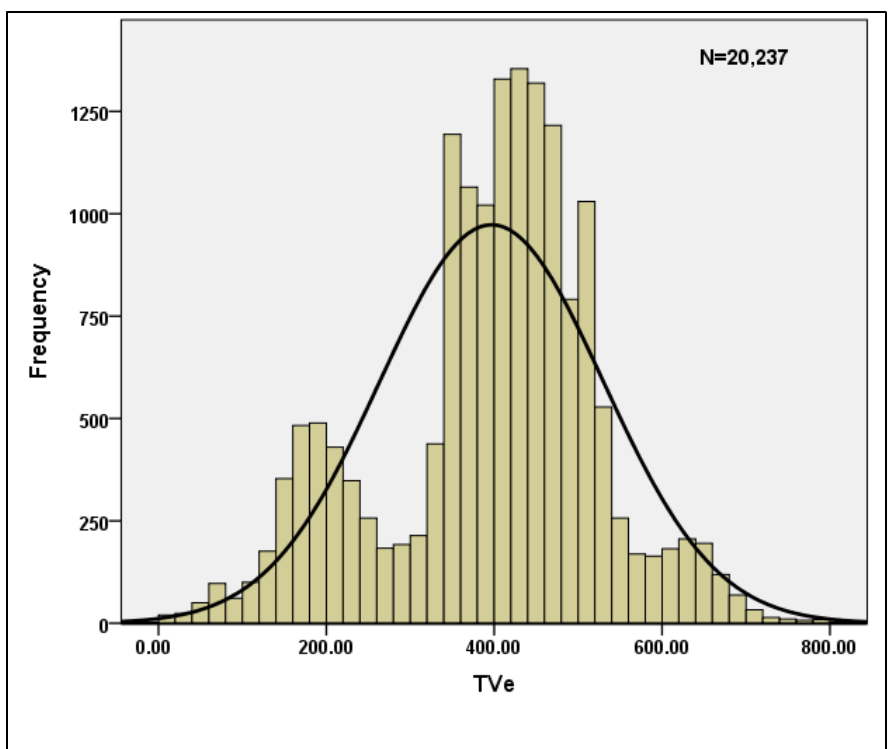
Figure 4. Normality plot for TVi.